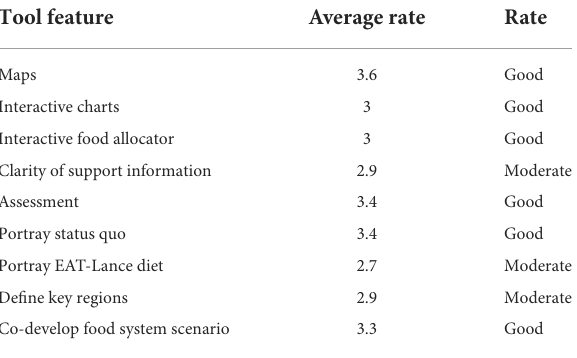
TABLE 5 MFP tool ratings: 1 denotes poor and 5